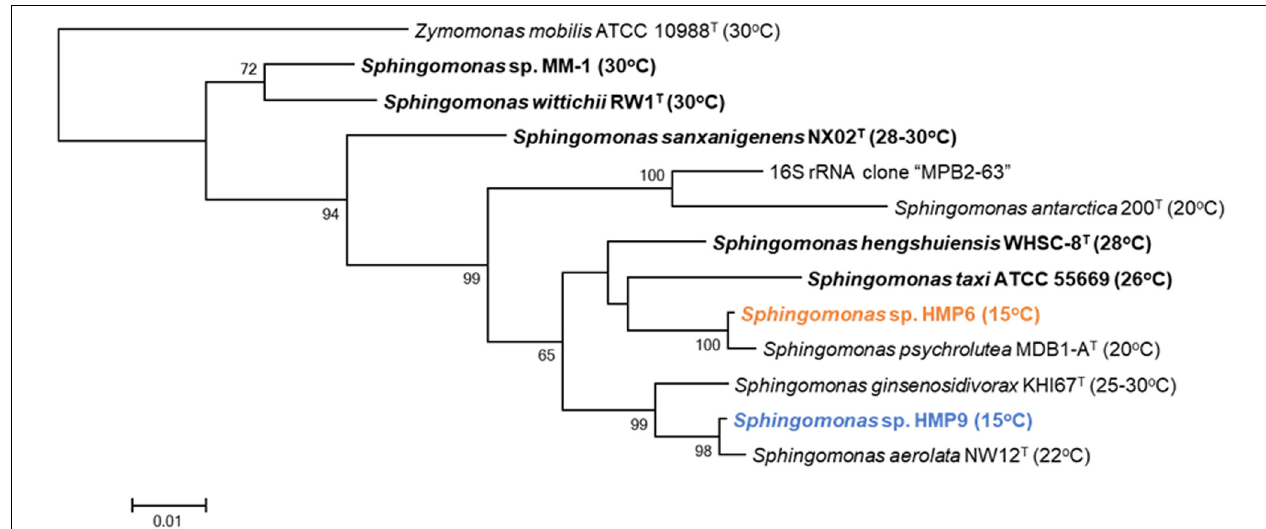
FIGURE 2 | Phylogenetic tree of the 12 Sphingomonas strains based on 16S rRNA sequence data constructed using the maximum-likelihood method under the Tamura-Nei model. Species names in bold are genome-sequenced strains. The numbers before the branching points correspond to bootstrap percentage values for 1000 replicates, whereas the superscript “T” indicates type strains. Values inside parentheses are the temperatures for optimum growth. Orange and blue text represents the Antarctic HMP6 and HMP9 strains, respectively.